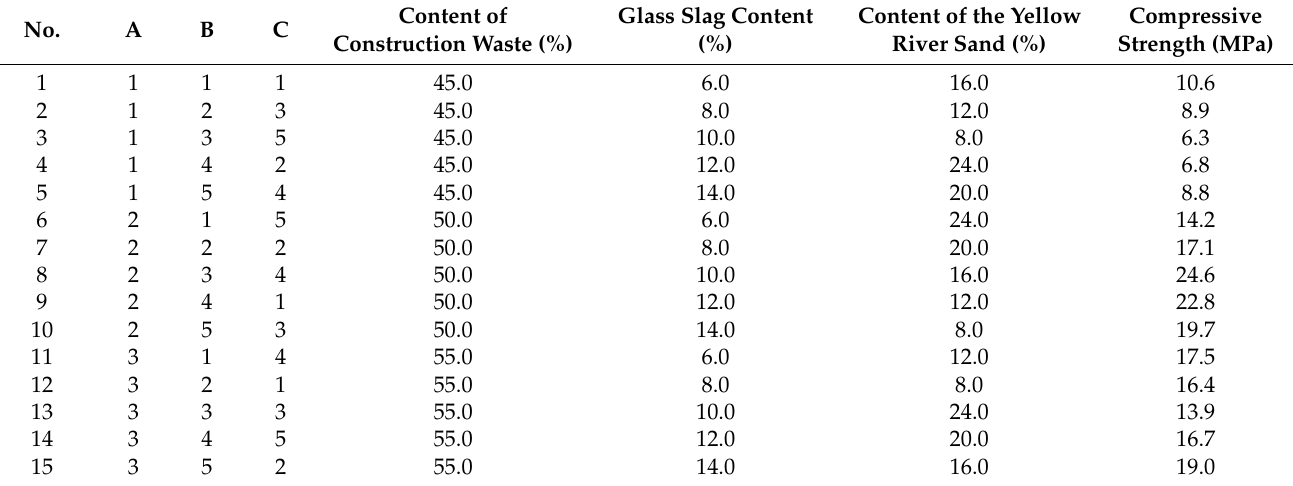
Table 7. Orthogonal experimental design and compressive strength test results.